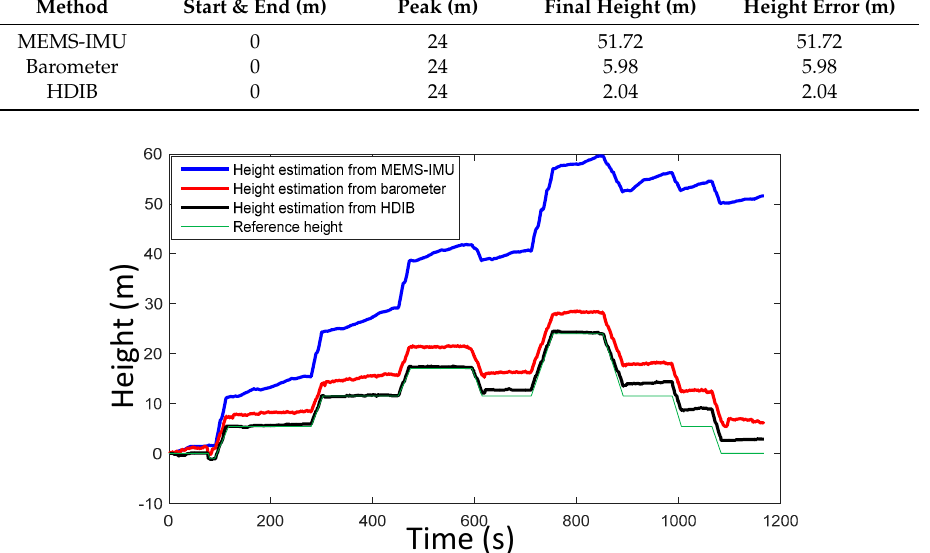
Figure 21. Height estimation using MEMS-IMU, barometer and HDIB. The blue line, red line and black line are height estimation from MEMS-IMU, barometer and HDIB, respectively. The green line is the reference height (true height).